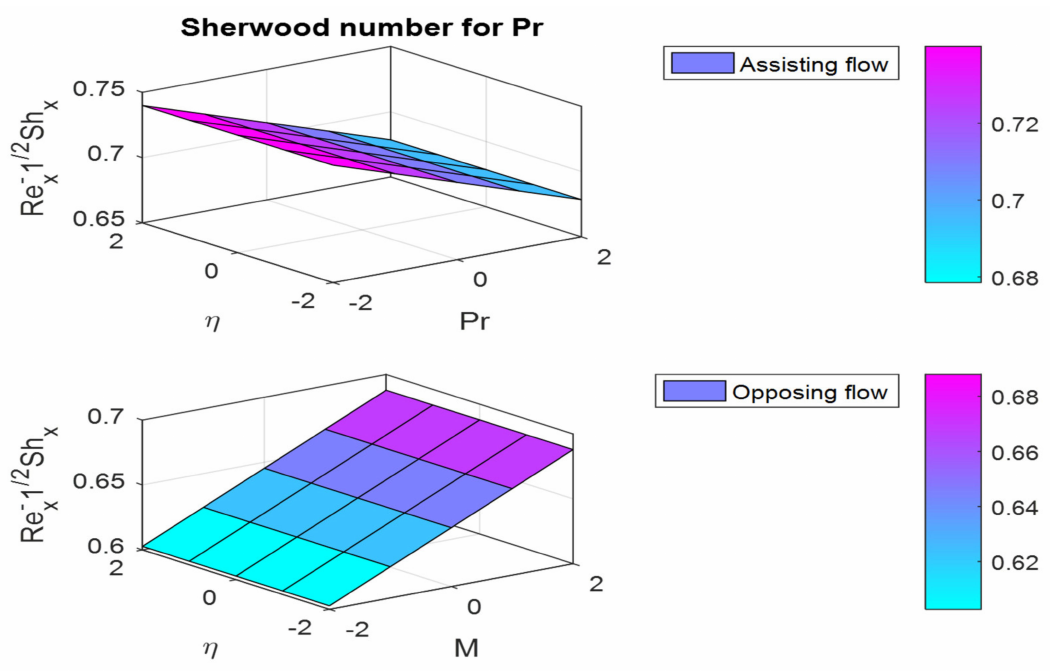
Figure 30. Surface plots for the φ (cid:48) ( 0 ) for dissimilar values of Pr. Figures 31–33 depict the friction factor coefficient, θ (cid:48) ( 0 ) , and φ (cid:48) ( 0 ) plots for different values of Nc 1 . Figure 31 represents that for increasing values of Nc 1 , the friction factor coefficient decreases in assisting and opposing flow cases. The rates of θ (cid:48) ( 0 ) and φ (cid:48) ( 0 ) rise as the Prandtl number increases in both cases.